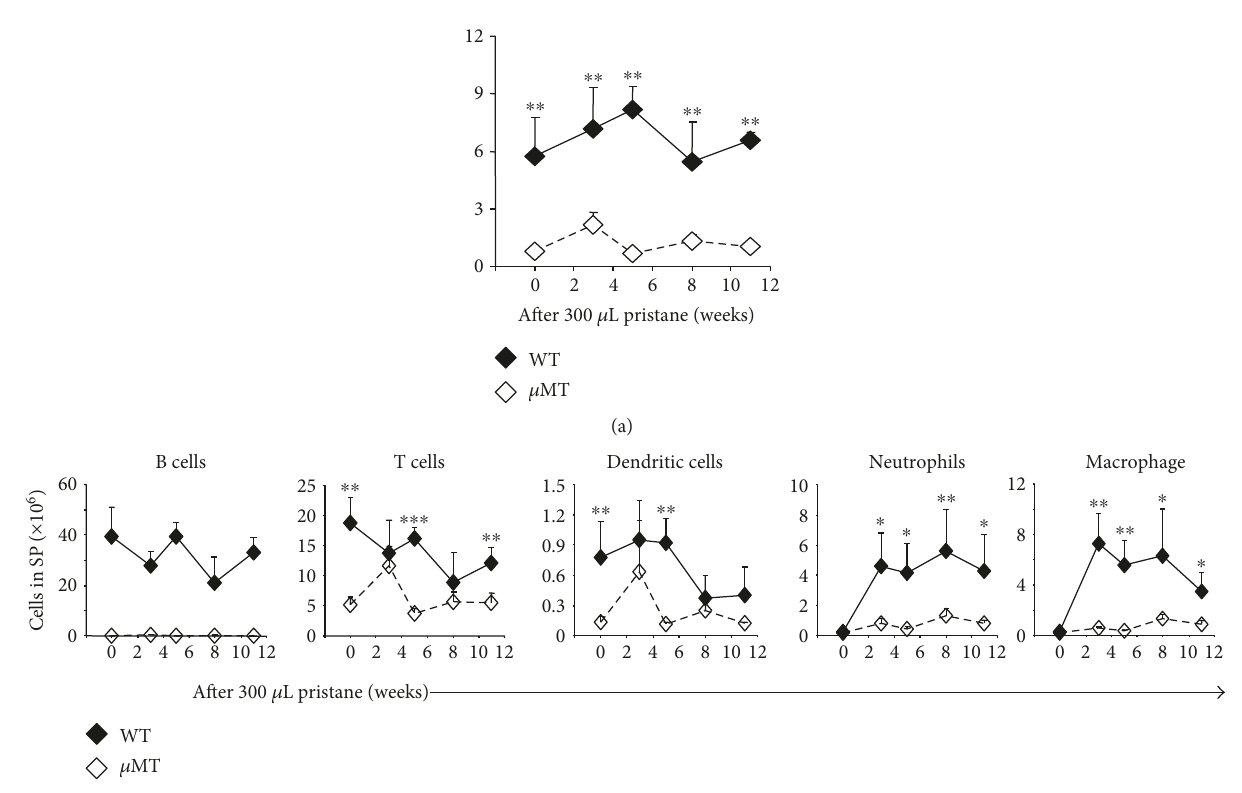
Figure 6: B cell loss reduced the cellularity of both leukocytes and lymphocytes during pristane-induced splenic in fl ammation. (a, b) μ MT mice and WT mice were injected with 300 μ L (8.3 × 10 − 4 mol) of pristane and were then sacri fi ced at the indicated time points. The total number of cells and the number of each cell type were calculated. The di ff erence between WT and μ MT mice is shown. Data represent two independent experiments. ∗ p < 0 05 , ∗∗ p < 0 01 , and ∗∗∗ p < 0 001